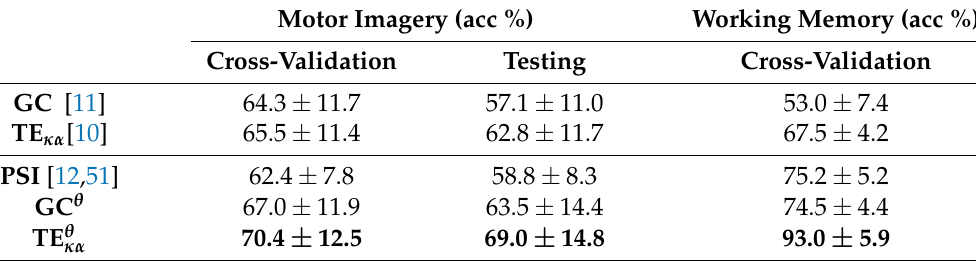
Table 1. MI and WM classification results in terms of the classification accuracy for all the effective connectivity measures considered.